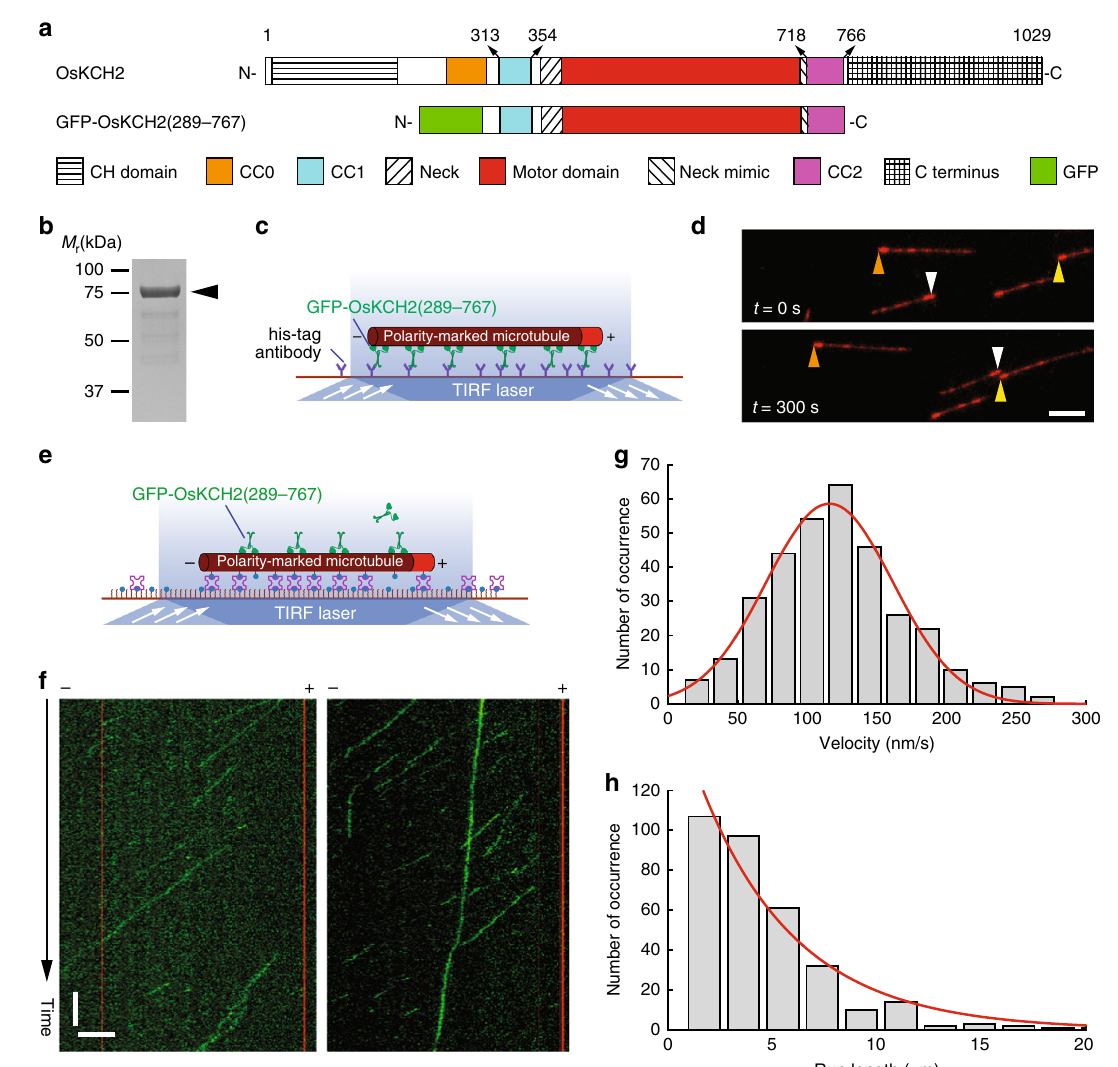
Fig. 2 GFP-OsKCH2(289-767) moves on the microtubule with minus-end-directed processive motility. a Schematic diagrams of the full-length OsKCH2 and GFP-OsKCH2(289 – 767). b Coomassie-stained SDS-PAGE of puri fi ed recombinant GFP-OsKCH2(289 – 767). c Schematic diagram of the ensemble microtubule gliding assay. d Micrograph montage showing the motion of polarity-marked microtubules (red) glided by surface-immobilized GFP-OsKCH2 (289 – 767). Arrowheads (brown, white, and yellow) indicate the plus ends of three different microtubules. e Schematic diagram of the single-molecule motility assay for observing the movement of individual GFP-OsKCH2(289 – 767) molecules on single microtubules. f Kymographs of single GFP-OsKCH2 (289 – 767) molecules (green) moving processively toward the minus end of single polarity-marked microtubules (red). g Velocity histogram of single GFP- OsKCH2(289 – 767) molecules. Red line indicates a Gaussian fi t to the velocity histogram. h Run-length histogram of single GFP-OsKCH2(289 – 767) molecules. Red line indicates a single-exponential fi t to the run-length histogram. Scale bars: 1 min (vertical) and 5 µ m